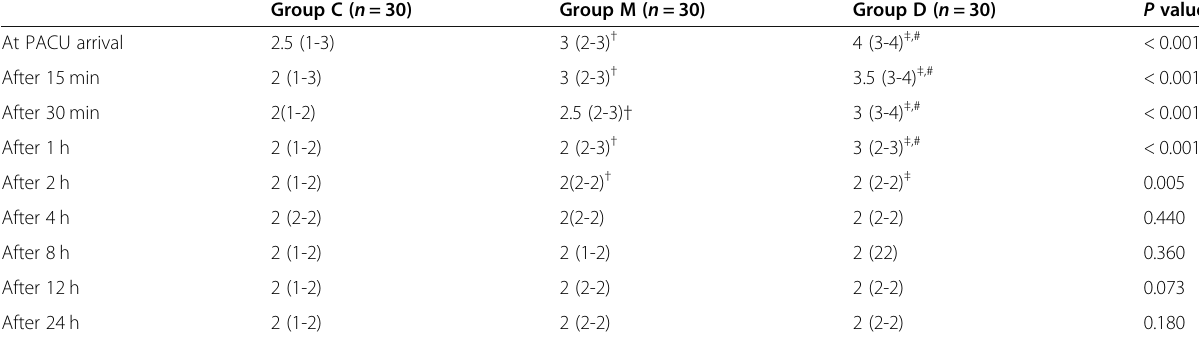
Table 7 Postoperative Ramsay sedation scores expressed as median (interquartile